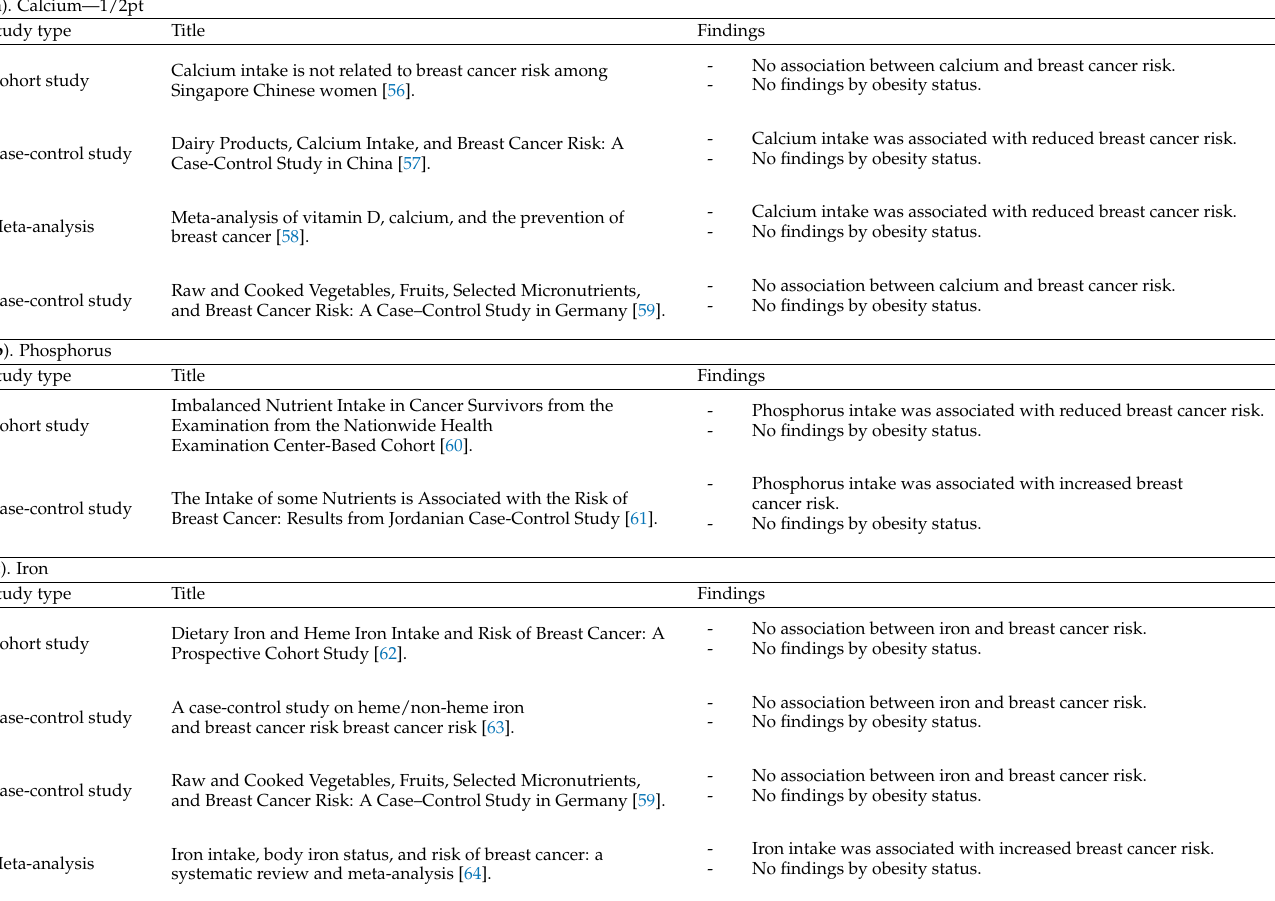
Table A3. Summary of previous studies on the association between nutrients and breast cancer risk by obesity